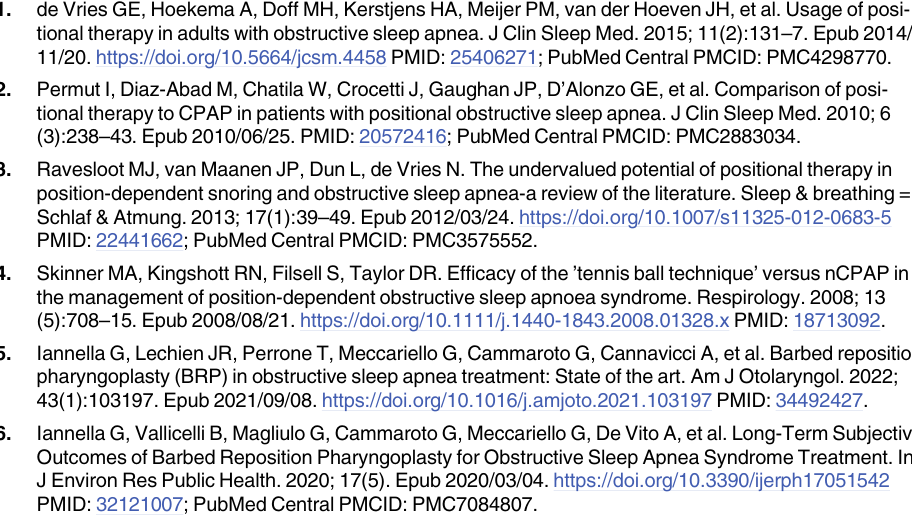
S2 Fig. The comparison between the improvement of the site of obstruction according to non-POSA and POSA groups. The POSA group showed significant improvement in supine to 30˚ and supine to 60˚ for tongue base compared to the non-POSA group. V, Velum; O, Oropharyngeal lateral walls; T, Tongue base; E, Epiglottis; Sup to 30, Supine to 30˚ head rota- tion; Sup to 60, Supine to 60˚ head rotation; 30 to 60, 30˚ to 60˚ head rotation. P-values of less than 0.05 denote as �